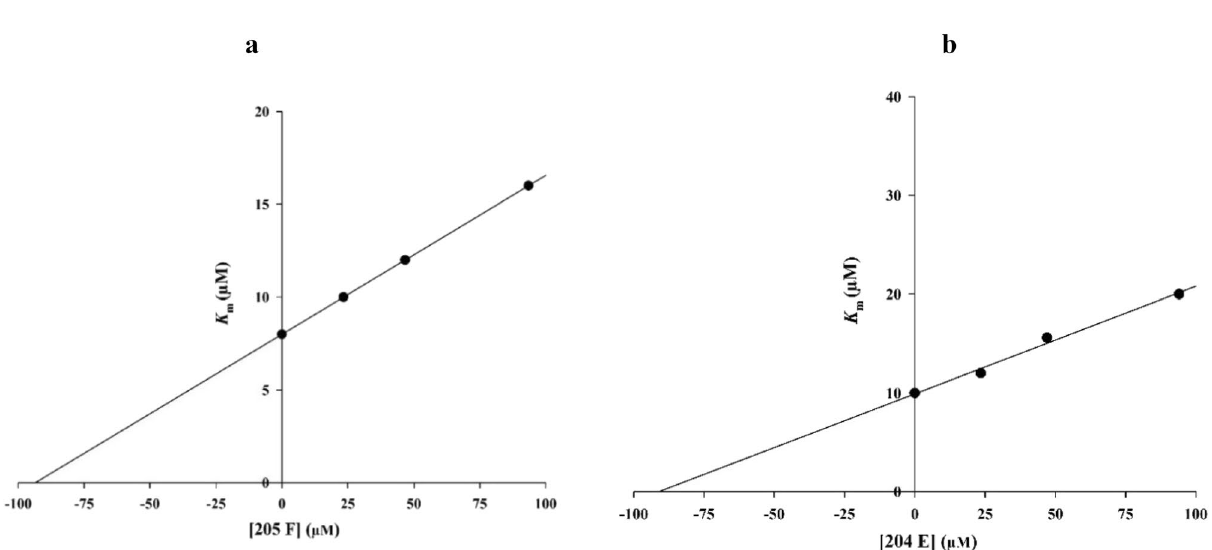
Figure 3. Kinetics of α-glucosidase inhibition by inhibitor. ( a ) The Lineweaver–Burk plot in the absence and presence of different concentrations of the 6m ( b ) The Lineweaver–Burk plot in the absence and presence of different concentrations of the 6l .